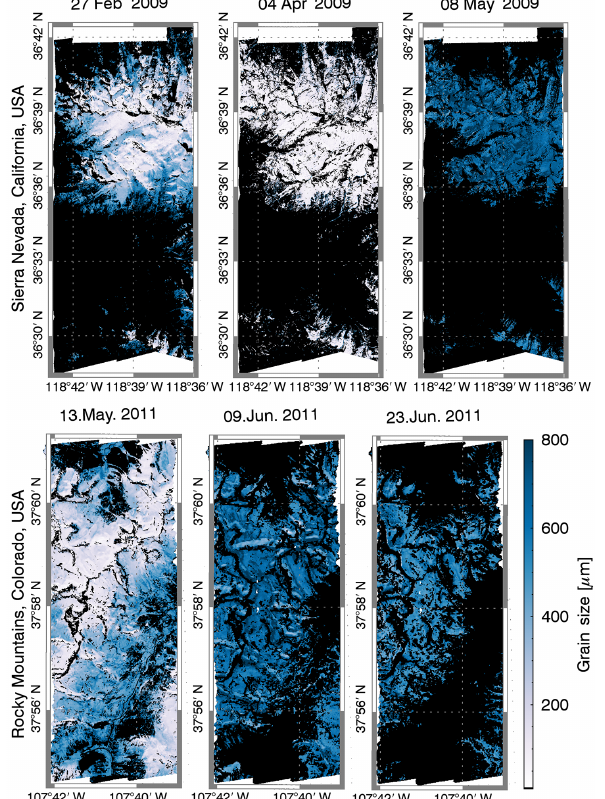
Figure 5. Same as Fig. 4 but for snow